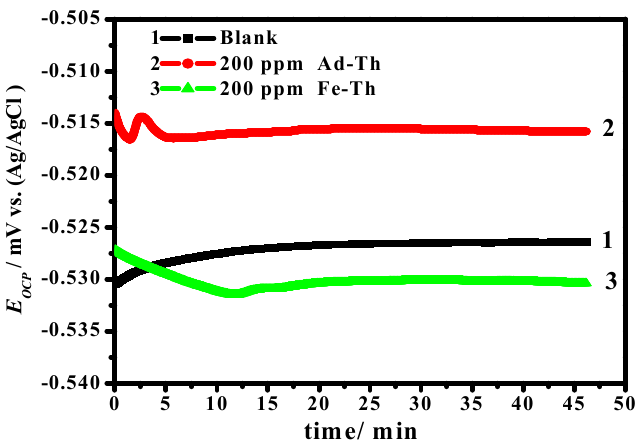
Figure 2. Variation of the OCP of C-steel in molar HCl with immersion time in the lack and occurrence of 200 ppm of Ad-Th and Fe-Th inhibitors at 50 °C.